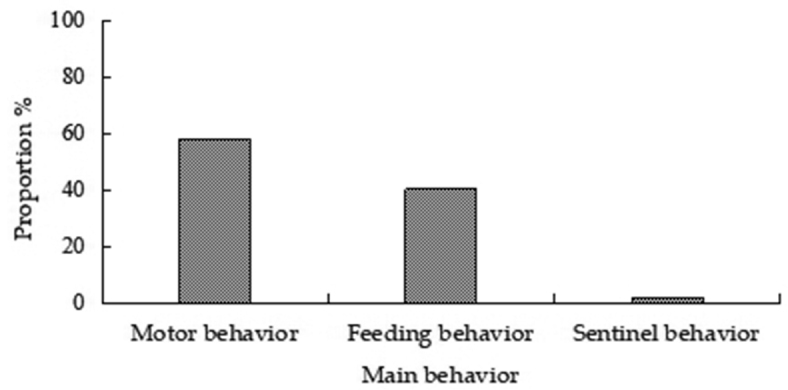
Proportion of three types behaviors of A.
peninsulae.